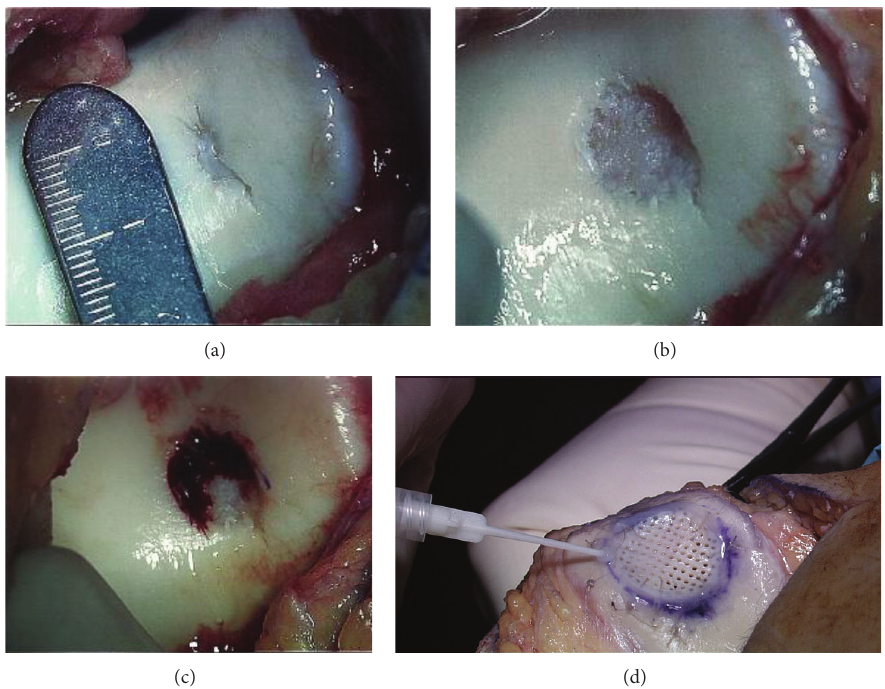
Figure 2: (a) Defect. The defect was inspected intraoperatively. The fissure in the trochlea measured approximately 5 mm in diameter and 10mm in length. (b) Removal of damaged cartilage. Loose fragmenting cartilage was removed until healthy, viable cartilage was encountered. The defect space then measured approximately 10mm by 10mm. (c) Marrow stimulation. The base of the defect was drilled to facilitate blood flow from the bone marrow into the defect space. (d) Chondral allograft application. This is a representative photo from a different case, demonstrating the final application of the chondral allograft. Note that the free edges of the chondral allograft were sutured to surrounding cartilage and a fibrin sealant was then applied to stabilize the chondral allograft within the lesion